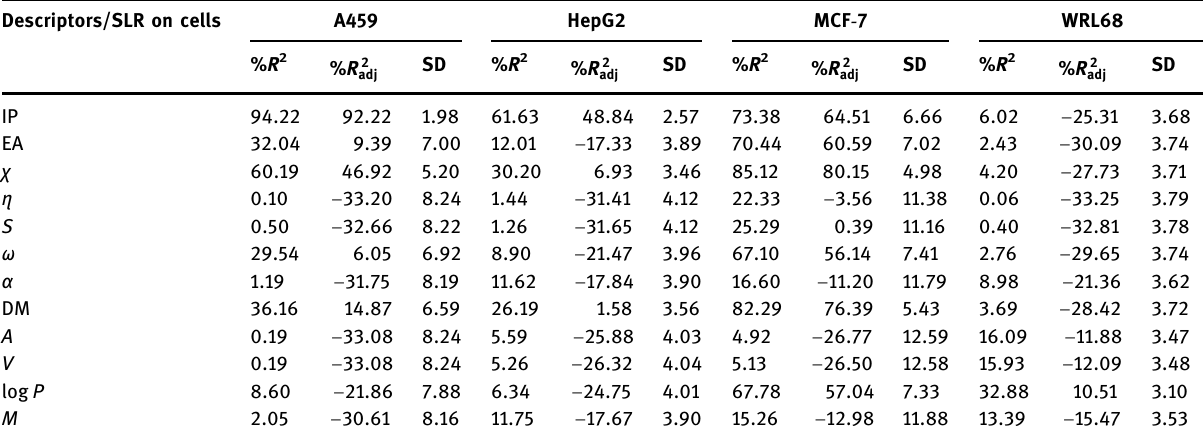
Table 6: Correlation coe ffi cients ( R 2 ) , adjusted correlation coe ffi cients